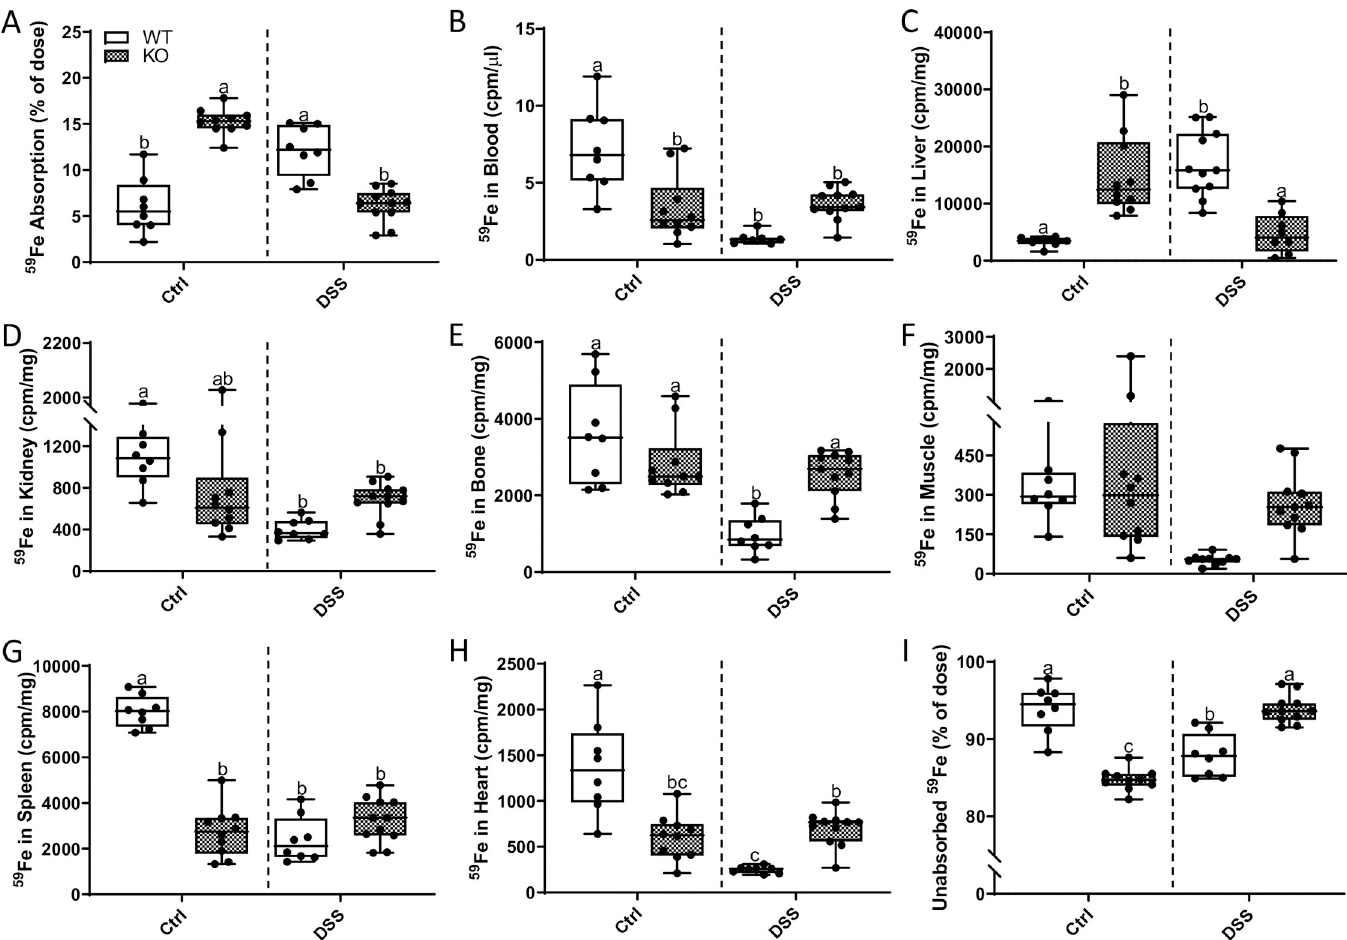
Fig 23. DSS treatment differentially influences intestinal 59 Fe absorption and tissue distribution in male WT and Hamp KO rats. Intestinal iron absorption and tissue distribution were assessed in 10-week-old male rats of both genotypes with and without intestinal inflammation. The absorption of a test dose of 59 Fe administered by oral, intragastric gavage is presented as the percentage of radioactivity present in the animals (minus 59 Fe trapped in the gut) 24 h after dosing ( A ). Distribution of 59 Fe in several tissues was also assessed by gamma counting ( B - H ). The percentage of unabsorbed 59 Fe is also depicted ( I ). All data are presented as box plots for 7–10 animals from two independent experiments and were analyzed by 2-way ANOVA followed by Tukey’s multiple comparisons post-hoc test. Groups labeled with different letters are significantly different from one another. Data that did not fit a normal distribution were transformed prior to performing statistical analyses. Genotype × Treatment, p < 0.0063 ( A-E, G-I ); Genotype p � 0.0428 ( A, G ); Treatment p � 0.0428 ( B, D, E-H